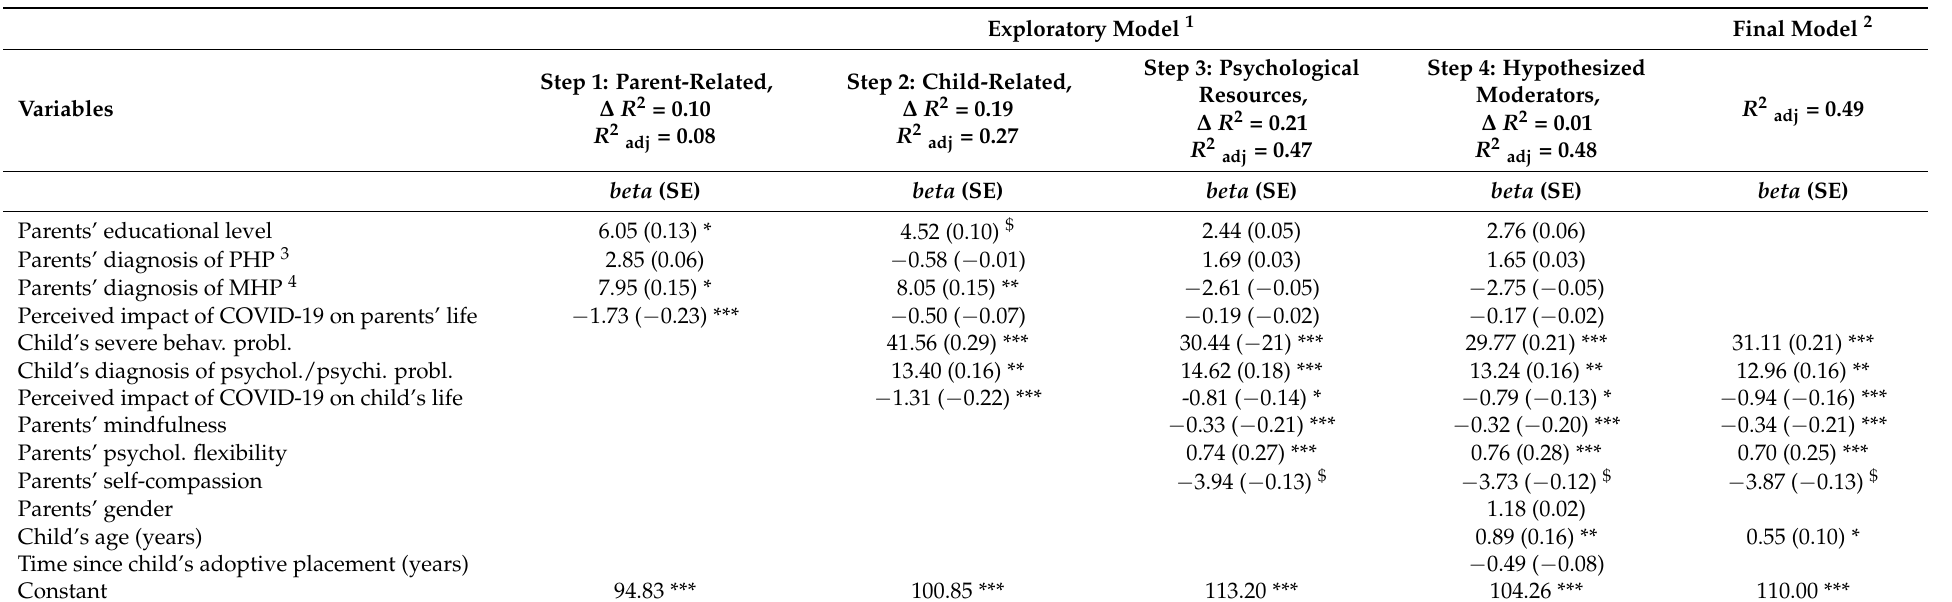
Table 3. Hierarchical Regression Models Explaining Parenting